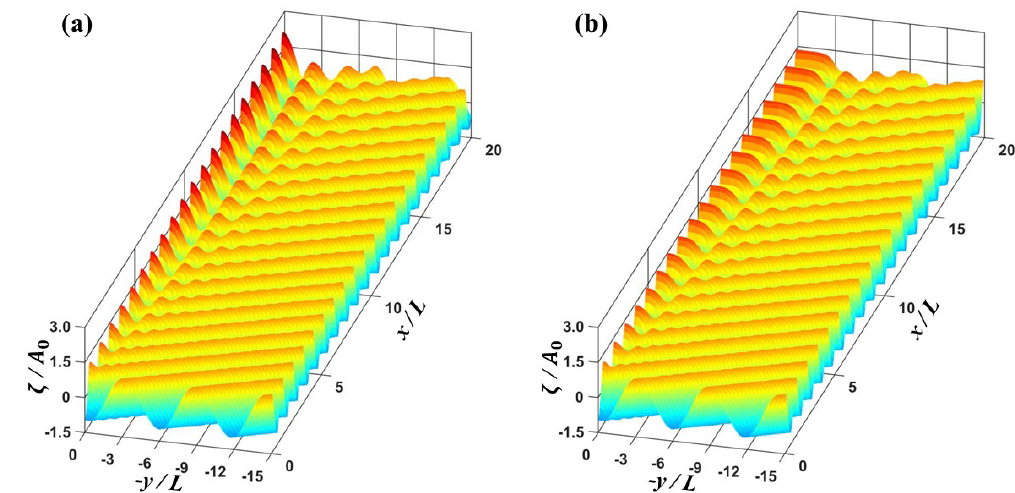
Figure 9. Three-dimensional plots of normalized free surface displacements (a) MLS1 and (b) MLL1 cases from